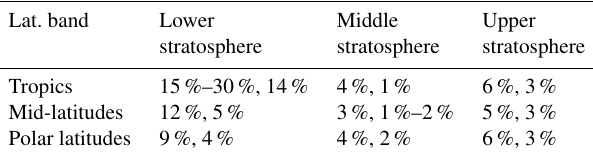
Table 3. Relative values of the estimated total random uncertainty due to parameter errors and retrieval noise for tropic, mid- and high latitudes, and for the lower, middle, and upper stratosphere. The first value indicates the total estimation (Eq. 11) and the second value indicates the retrieval noise component (from Fig. 1). Lat.